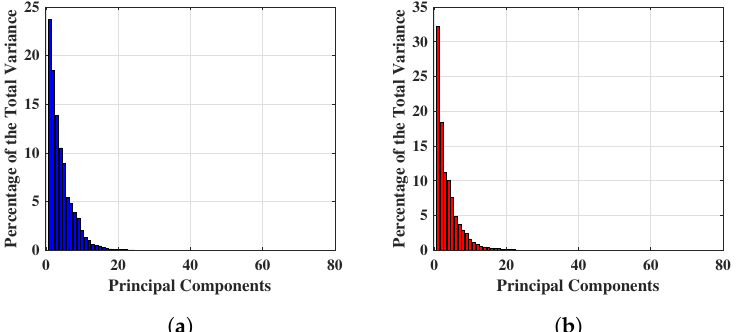
Figure 7. Example of significant variance achieved applying PCA on real part of complex S 21 signals.